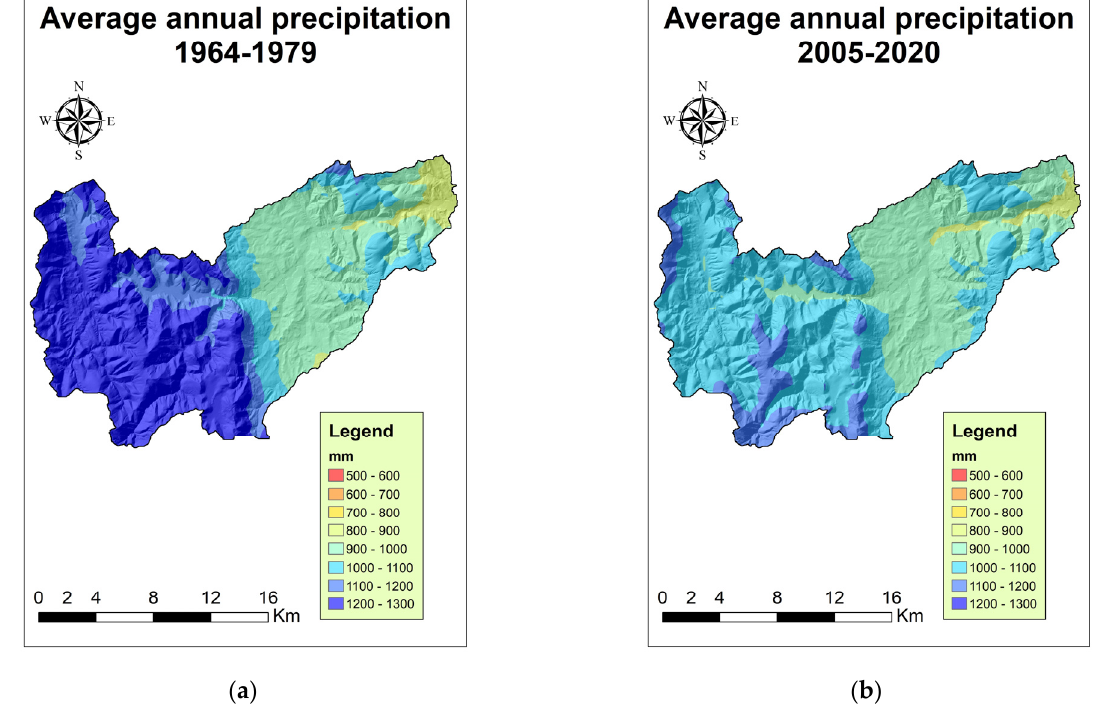
Figure 6. A verage annual precipitation: ( a ) 1964–1979; ( b ) 2005–2020. Figure 6. Average annual precipitation: ( a ) 1964–1979; ( b )